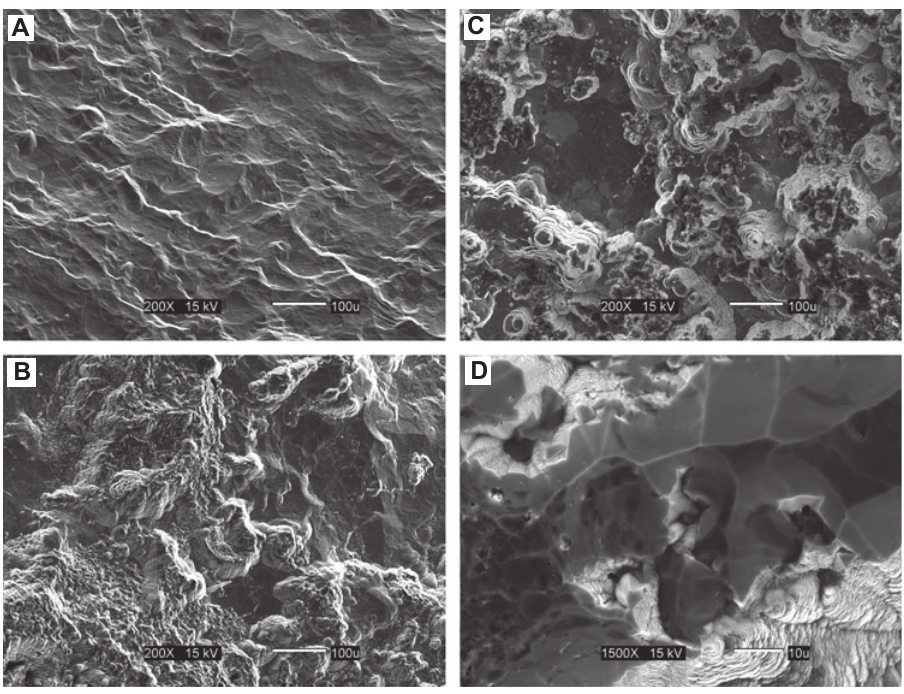
Figure 4 Secondary electron SEM micrographs of the targets after argon plasma bombardment: (A) aluminum; (B) diboride-containing target; (C) dodecaboride-containing target; (D) blow up of the rectangular region in (C).